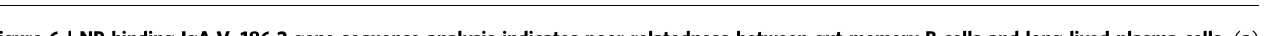
Figure 6 | NP-binding IgA V H 186.2 gene sequence analysis indicates poor relatedness between gut memory B cells and long-lived plasma cells. ( a